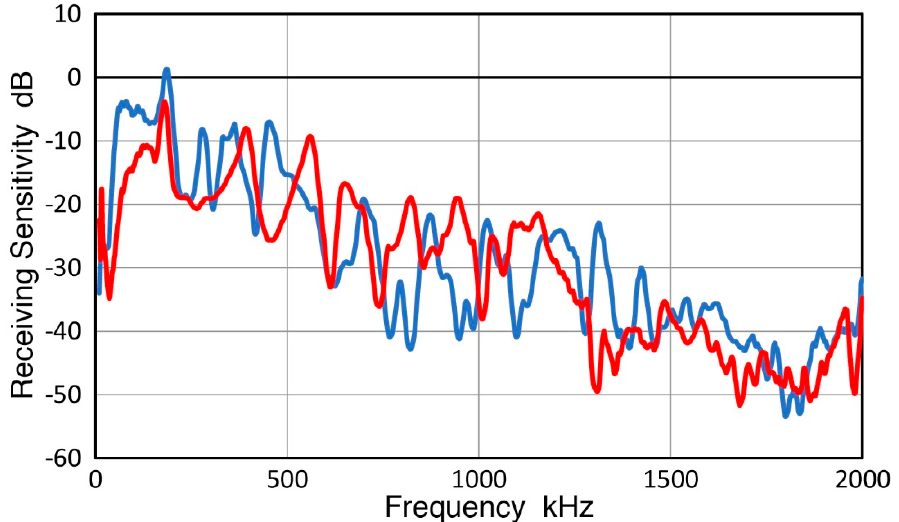
Figure 12. RW receiving sensitivity (0 dB in reference to 1 nm displacement) of two piezoelectric ceramic disks. Red curve: 12.7 mm diameter, 2 mm thick; blue curve: 11.4 mm diameter, 5.15 mm thick.